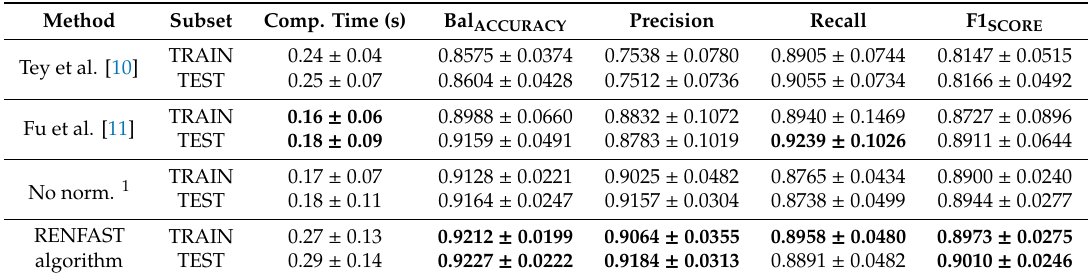
Figure 7. Blood vessel detection performed by state-of-the-art methods and the proposed algorithm. Two different samples are displayed in the first rows, while the last row shows a zoom of the segmentation near the blood vessel contour. Table 4. Comparison between the proposed algorithm and the current state of the art for fibrosis segmentation (pixel-based